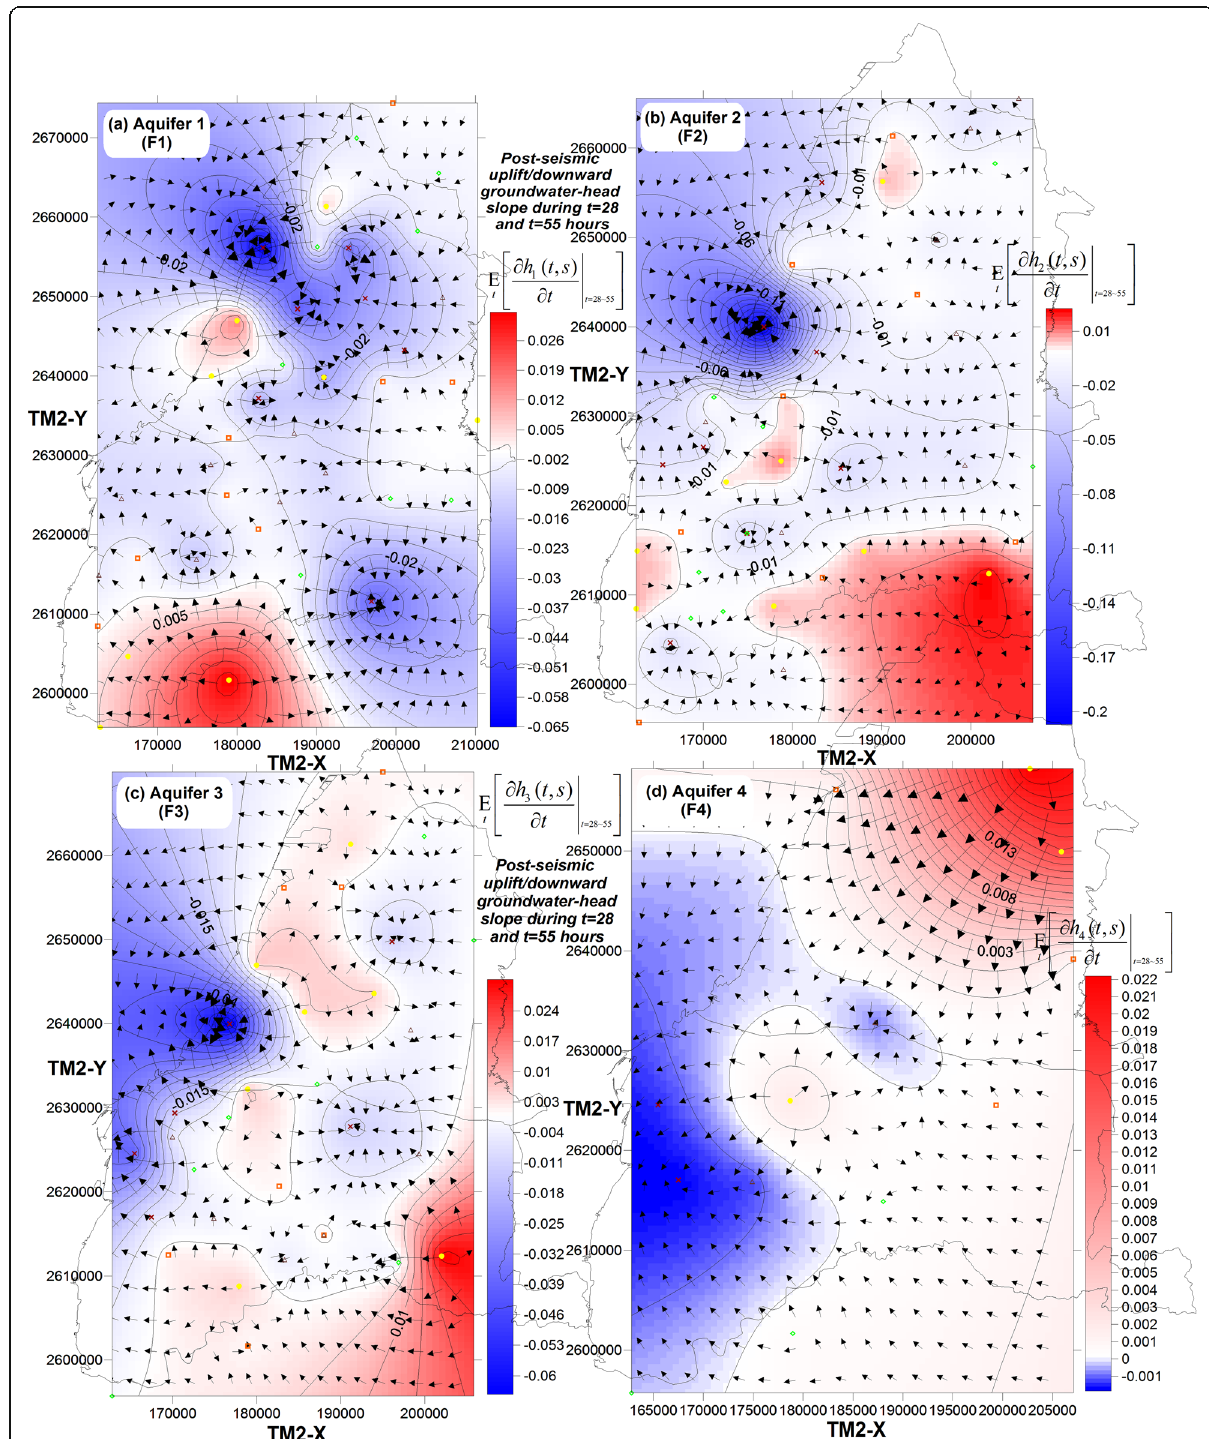
Fig. 10 The investigated pattern of post-seismic uplift/downward partial derivatives of groundwater head vs. time during t = 28 and t = 55 across multiple